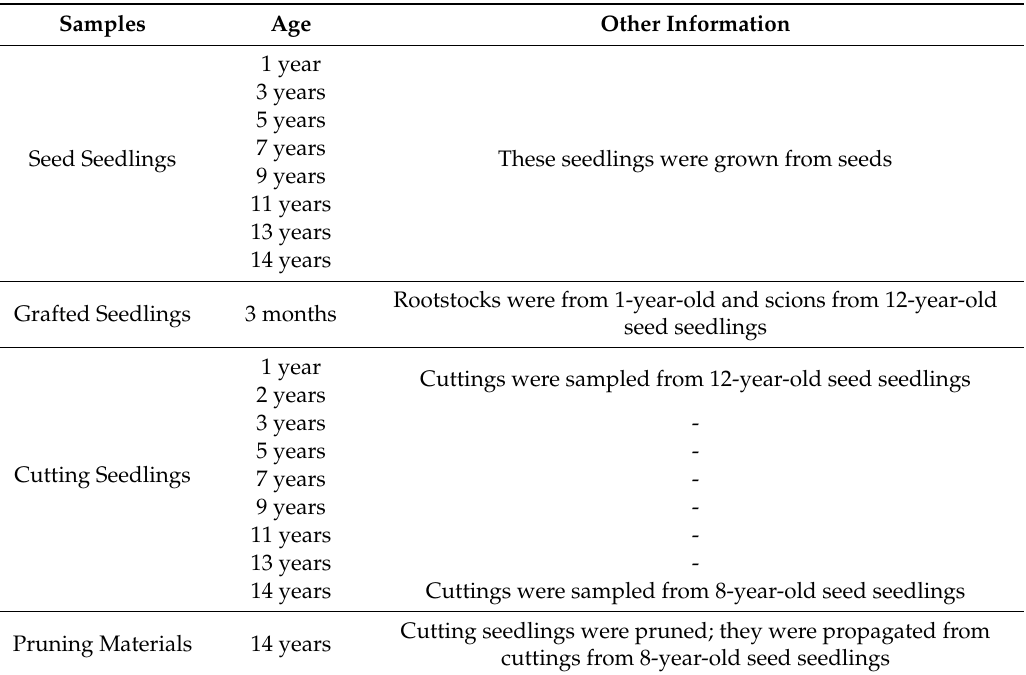
Table 1. Information on